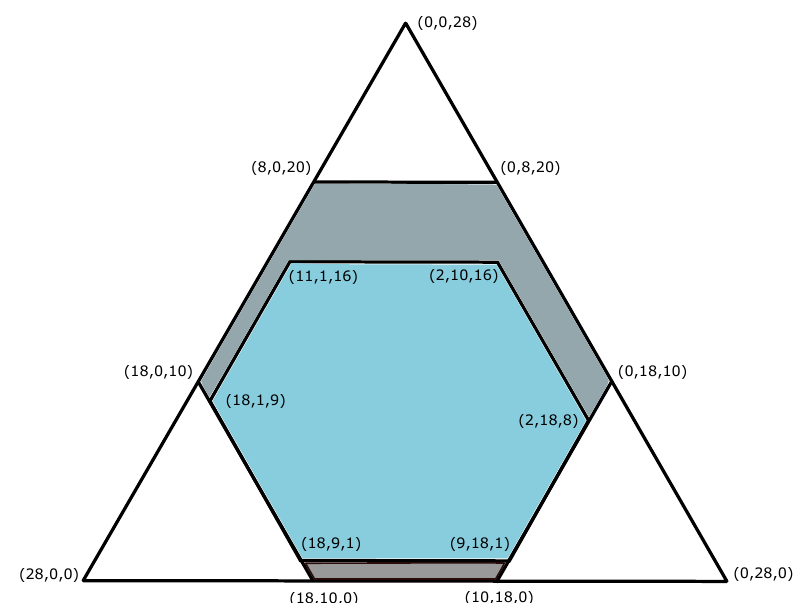
Figure 2. The core C ( ω 1 ) (gray region) and approximated core D ( ω 1 ) (blue region inside gray region) for ω 1 state game.